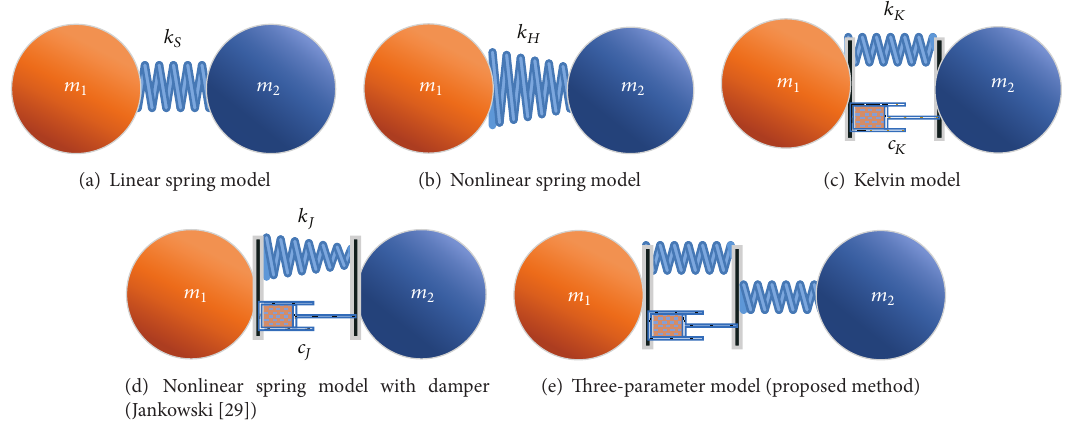
Figure 2: Pounding force